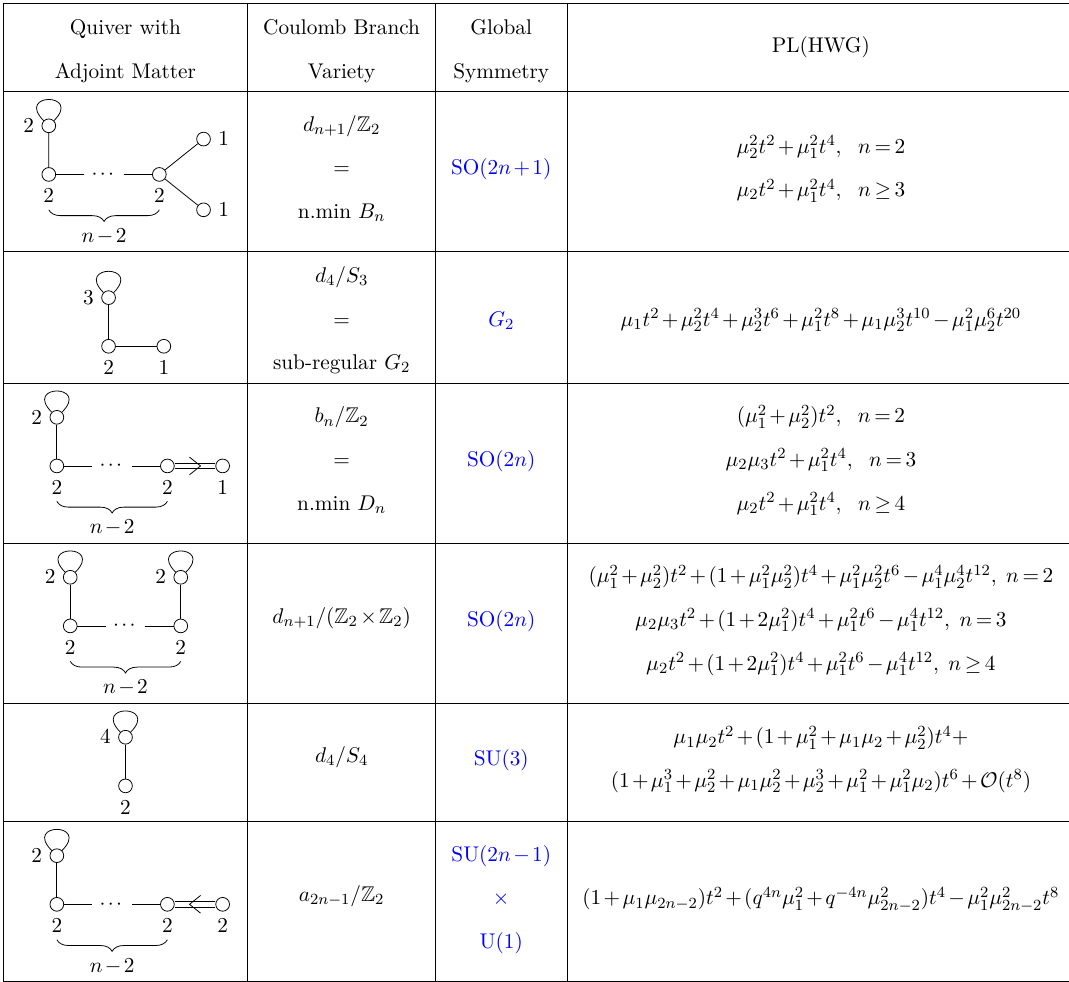
Table 3 . The full list of balanced unframed unitary 3 d N = 4 quivers with l ∈ N { 0 } nodes that each have a single adjoint hypermultiplet but which otherwise contain only regular